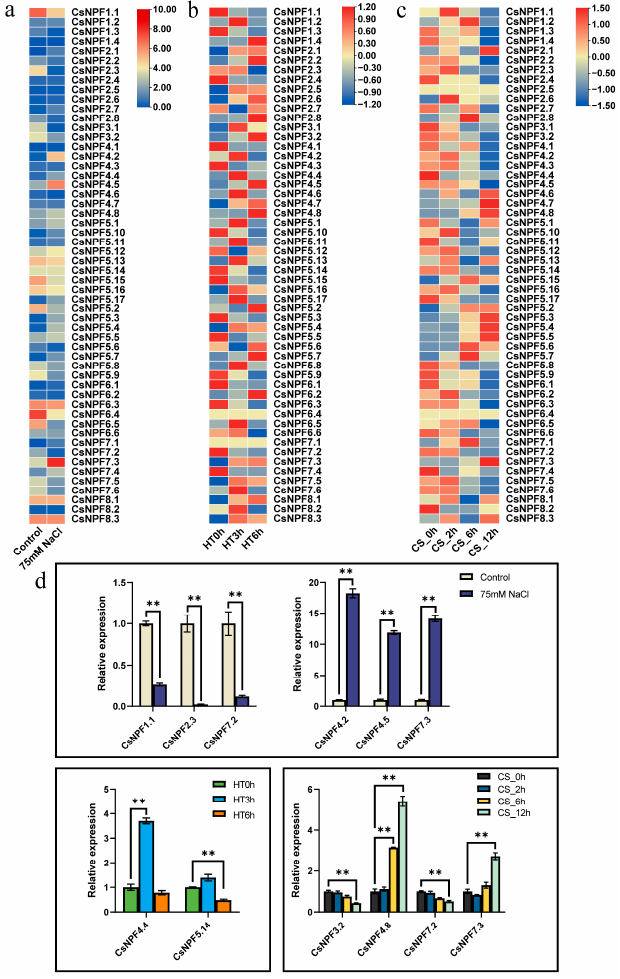
Figure 7. Expression profiles of CsNPF genes in response to various abiotic stress treatments. ( a ) Salt stress. ( b ) Heat stress. ( c ) Cold stress. Gene expression levels were evaluated as log2 − transformed FPKM values. CK, control; 75 mM NaCl, 75 mM NaCl treatment after 24 h; HT0h, heat treatment for 0 h; HT3h, heat treatment for 3 h; HT6h, heat treatment for 6 h; CS_0h, untreated; CS_2h, exposed to an air temperature of 6 ◦ C for 2 h; CS_6h, exposed to an air temperature of 6 ◦ C for 6 h; CS_12 h, exposed to an air temperature of 6 ◦ C for 12 h; ( d ) Relative expression levels of 10 CsNPF genes under salt, heat,